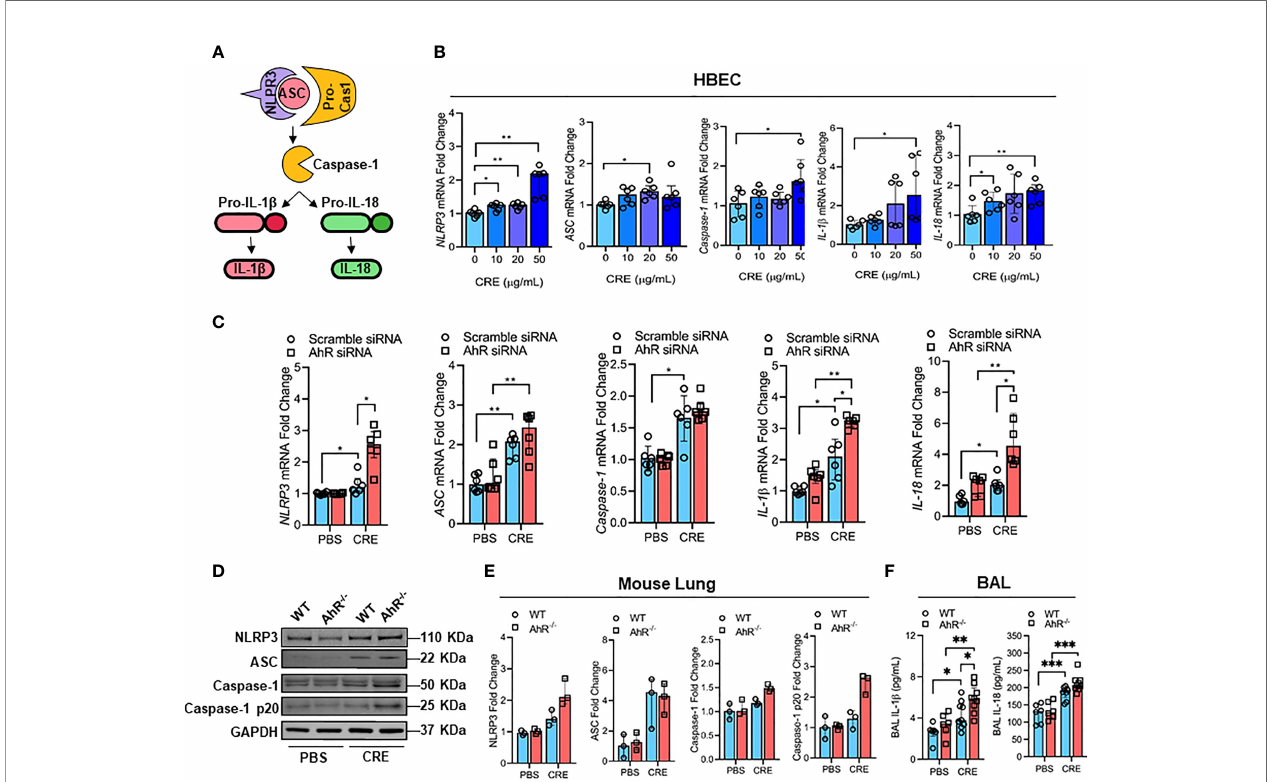
FIGURE 4 | AhR protects against cockroach allergen-induced NLRP3 in fl ammasome in airway epithelial cells . (A) Scheme for NLRP3 in fl ammasome activation. (B) Cockroach allergen-induced NLRP3 in fl ammasome activation as detected by RT-PCR (n = 6). (C) Expression of NLRP3 in fl ammasome components in cockroach extract (CRE, 50 µg/ml)-treated HBECs with or without AhR knockdown as detected by RT-PCR (n = 6). (D) Western blot analysis of NLRP3 in fl ammasome components in the lung tissues of cockroach allergen-induced mouse model with wild-type (WT) and AhR -/- mice. (E) Quantitative analysis of western blots (E) , n = 3]. (F) Levels of IL-1 b and IL-18 in the BAL fl uids of cockroach allergen-induced mouse model with wild-type (WT) and AhR -/- mice (n = 6-9). Data represent as medians with interquartile (IQR) (B, C, E) or means ± SEM (F) . * P < 0.05, ** P < 0.01, *** P <